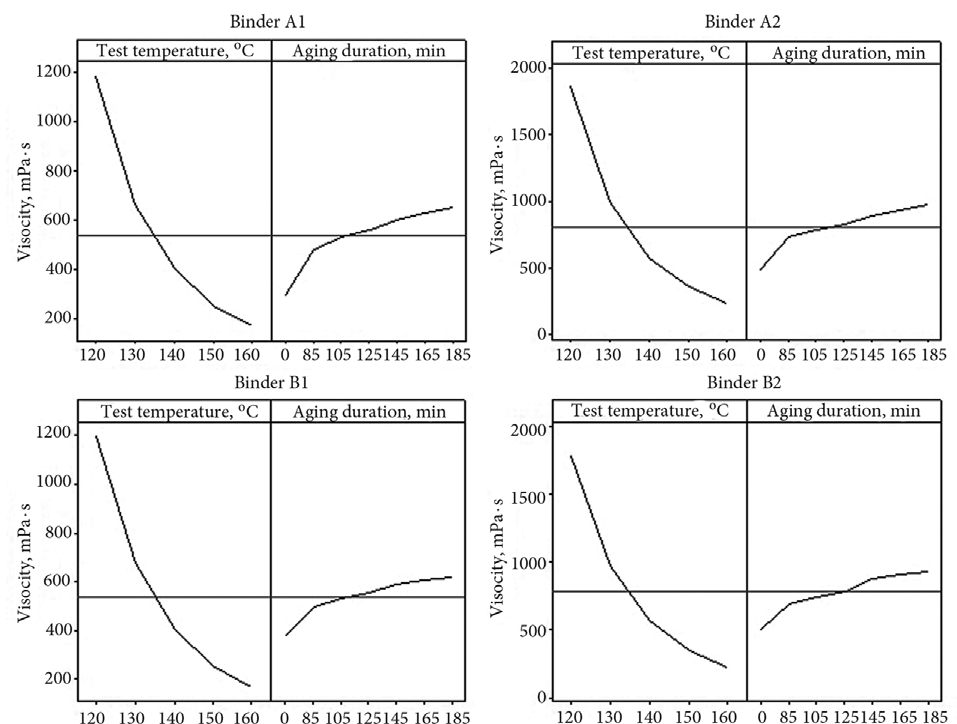
Fig. 2. The main effects of test temperature and aging duration on viscosity of binders A1, A2, B1 and